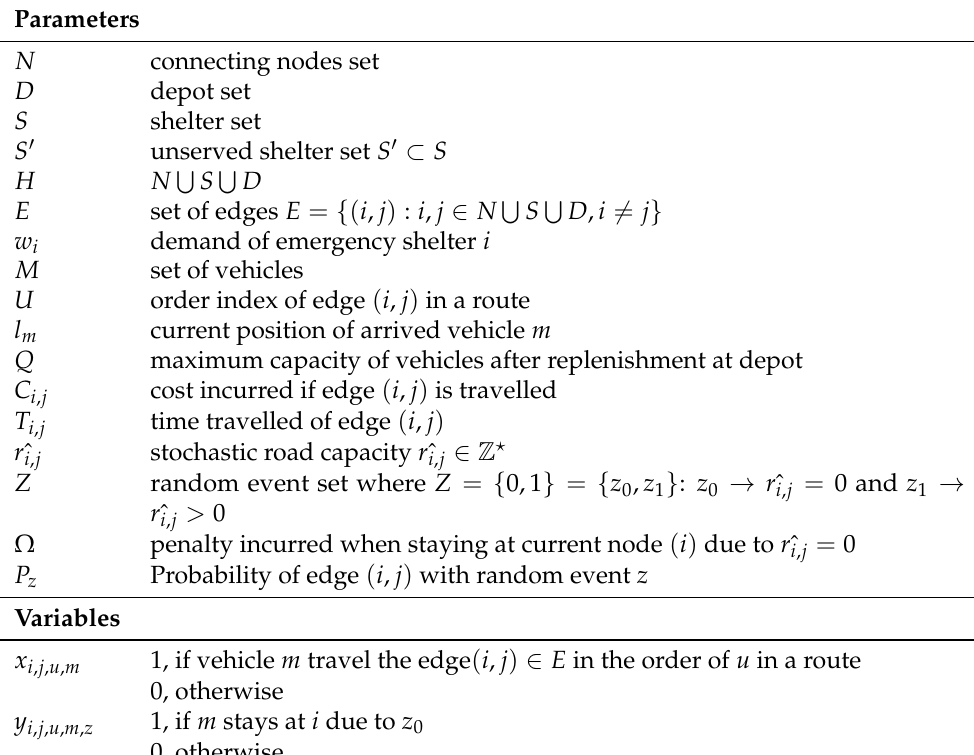
Table 2. Parameters and Variables for MDVRPSRC-2S1 and MDVRPSRC-2S2.